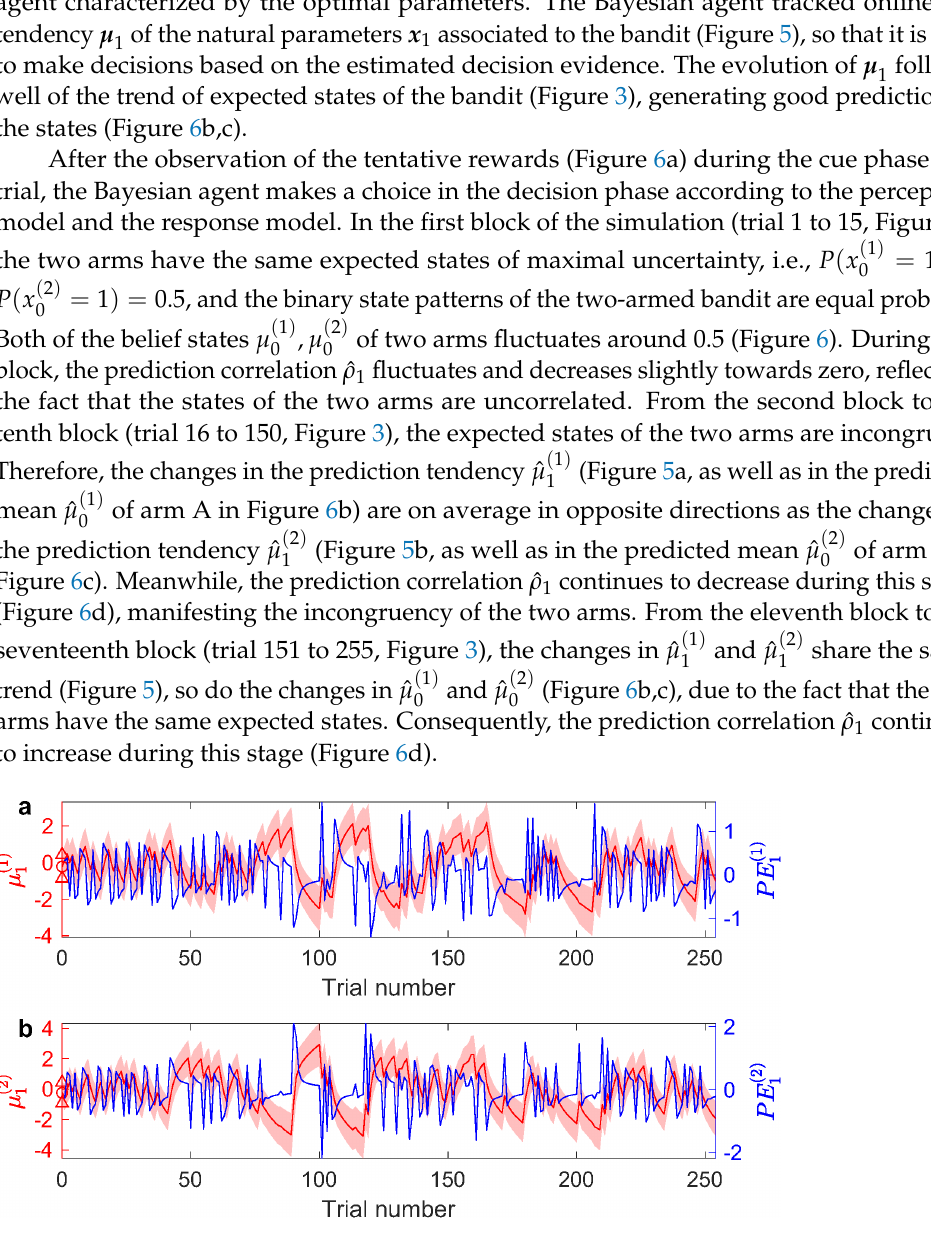
of the natural parameter at the first level. ( a ) The 1 , is shown in red. The time-varying trajectory of the 1 ( 2 ) , the second component of µ , is 1 1 ( 2 ) is shown in blue. Light-red 1 (cid:113) ( i ) ( i , i ) ( t ) ( t ) , i C 1,2 ). The red 1 1 ± ∈ { }